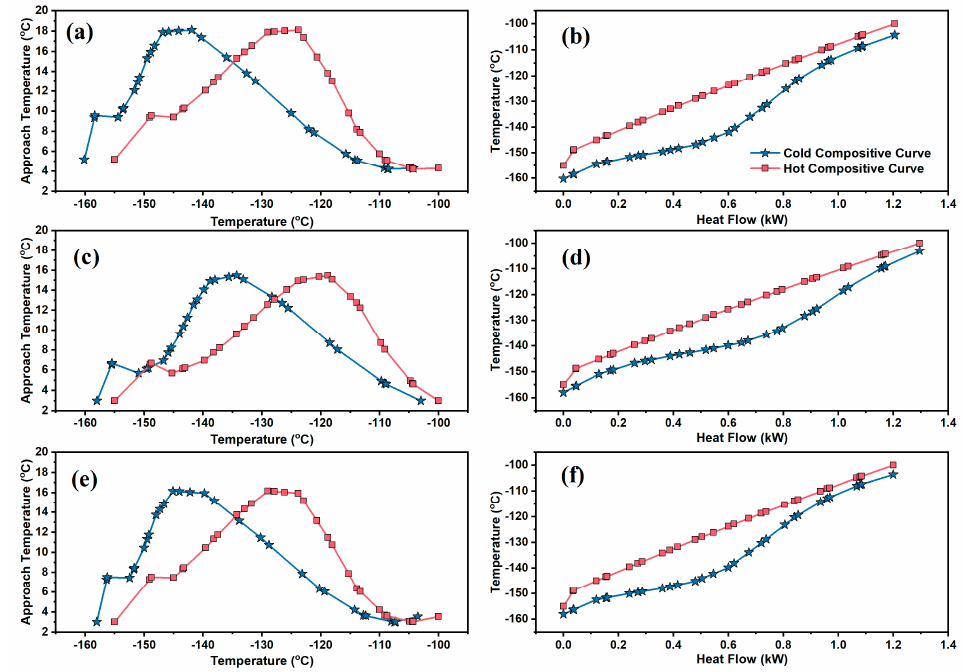
Figure 6. TDCC and THCC of ( a ) and ( b ) the base case, ( c ) and ( d ) SCE-optimized process corresponding to 300 iterations and ( e ) and ( f ) SCE-optimized process corresponding to 700 iterations, for the sub-cooling heat exchanger of MFC–LNG process.